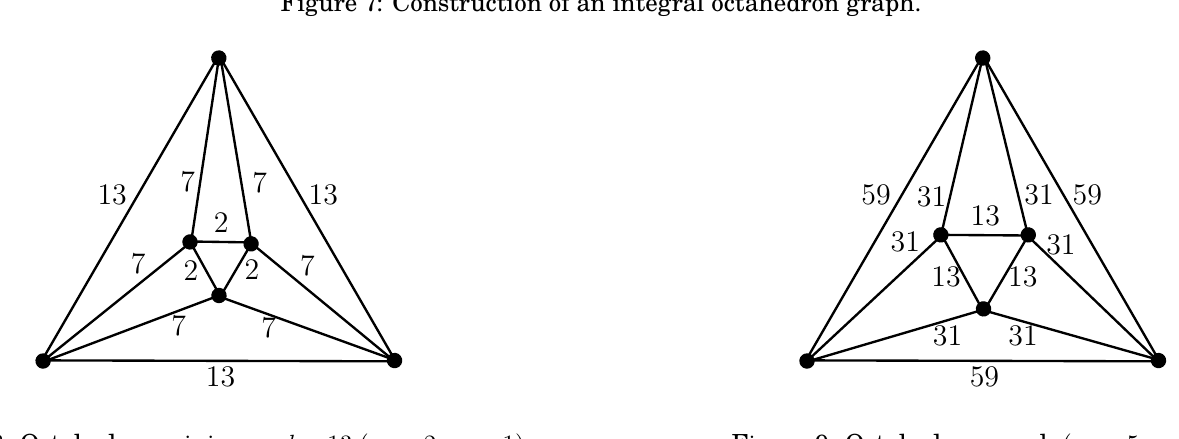
Figure 8: Octahedron minimum d = 13 ( m = 2 , n = 1) . Figure 9: Octahedron graph ( m = 5 , n = 1)